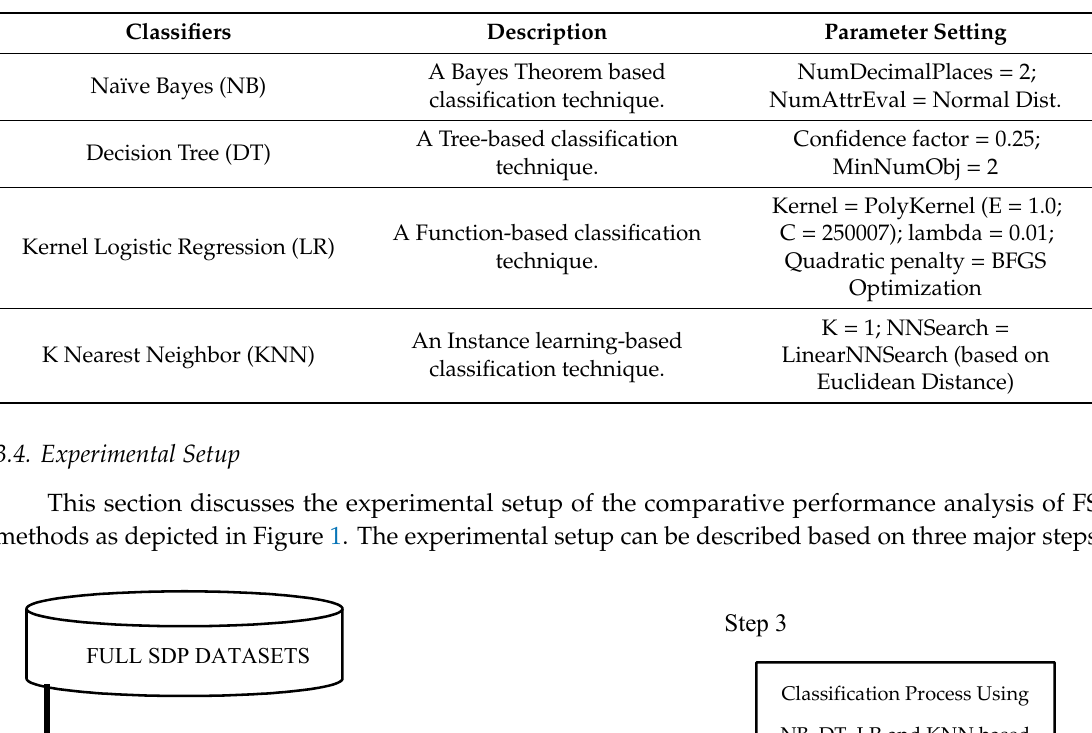
Table 4. Classification Algorithms.